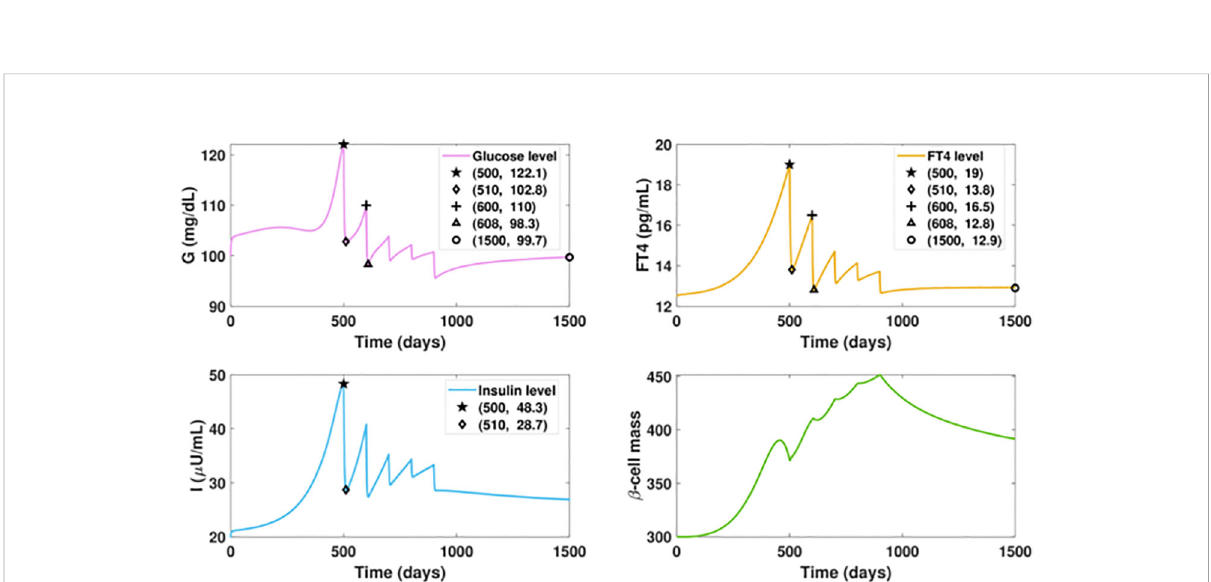
FIGURE 7 Dynamics of altered glucose, insulin, and functional beta-cell mass levels with timely treated hyperthyroidism. The ATD dosage D is designed as a piecewise function in the following pattern: D = 0, for t ≤ 500; D = 3, for 500< t ≤ 600; D = 8, for 600< t ≤ 700; D = 12, for 700< t ≤ 800; D = 15, for 800< t ≤ 900; D = 20, for t > 900. The parameter values in the drug intervention term are: d 3 = 1, IC 50 = 30. All the other parameter values and initial conditions remain the same as those in Figure 5. The initial rise of FT4 level would cause a temporary upsurge of glucose level around the initial point, which is then quickly counterbalanced by the fast increase of insulin levels. In contrast with the increasing trend of the glucose level in Figure fFT4fastProgressingHyper(a), the administration of 3mg ATD drug after day 500 can drag the FT4 level down by 5.2 pg/ ml in 10 days, followed by the 19.3 units reduction of glucose level and 19.6 units decrease of insulin level. However, the dose is not enough to prevent the FT4 level from increasing after day 510, which would result in the rise of glucose. We then increase the ATD dose to 5 mg after day 600. As a result, the elevated dosage would drive the FT4 down close to its set point value, and the glucose level would decrease again. Yet this level of treatment is insuf fi cient as the inherent deterioration of the thyroid remains. To enhance the treatment, an increased dosage is applied every one hundred days until day 900 when the dosage becomes fi xed. At the end, the FT4 level approaches the steady state with 12.9 pg/ml and the glucose level would be regulated within the normal range after day